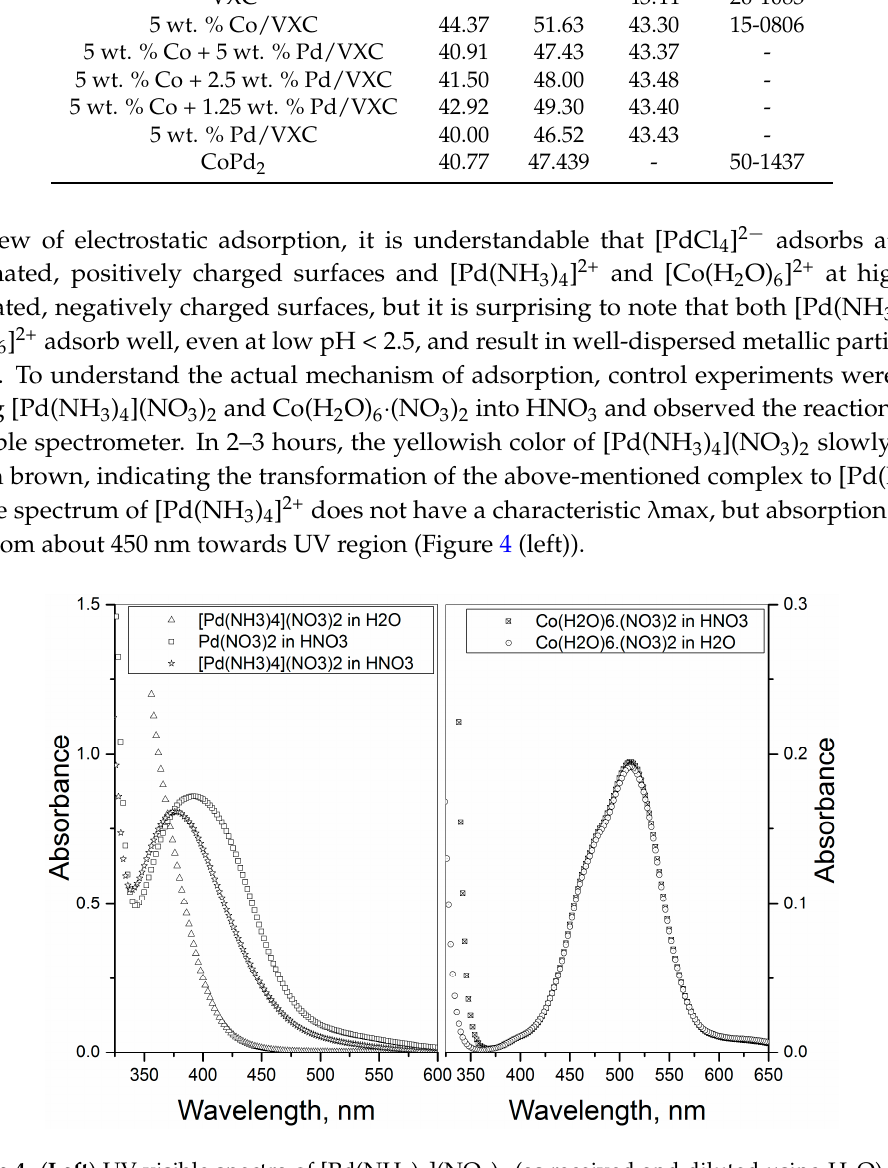
Figure 4. ( Left ) UV ‐ visible spectra of [Pd(NH 3 ) 4 ](NO 3 ) 2 (as received and diluted using H 2 O), pure Pd(NO 3 ) 2 in 1 M HNO 3 and [Pd(NH 3 ) 4 ](NO 3 ) 2 in 1 M HNO 3 . ( Right ) 10 mM Co(H 2 O) 6 (NO 3 ) 2 in 1 M HNO 3 and distilled H 2 O.